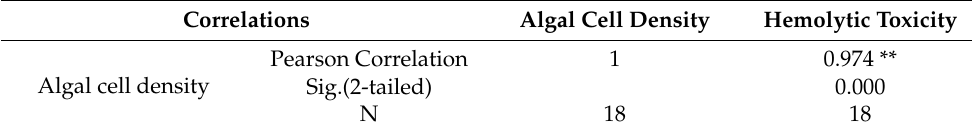
Table 1. The relationship between hemolytic toxicity and the cell density of K. mikimotoi.